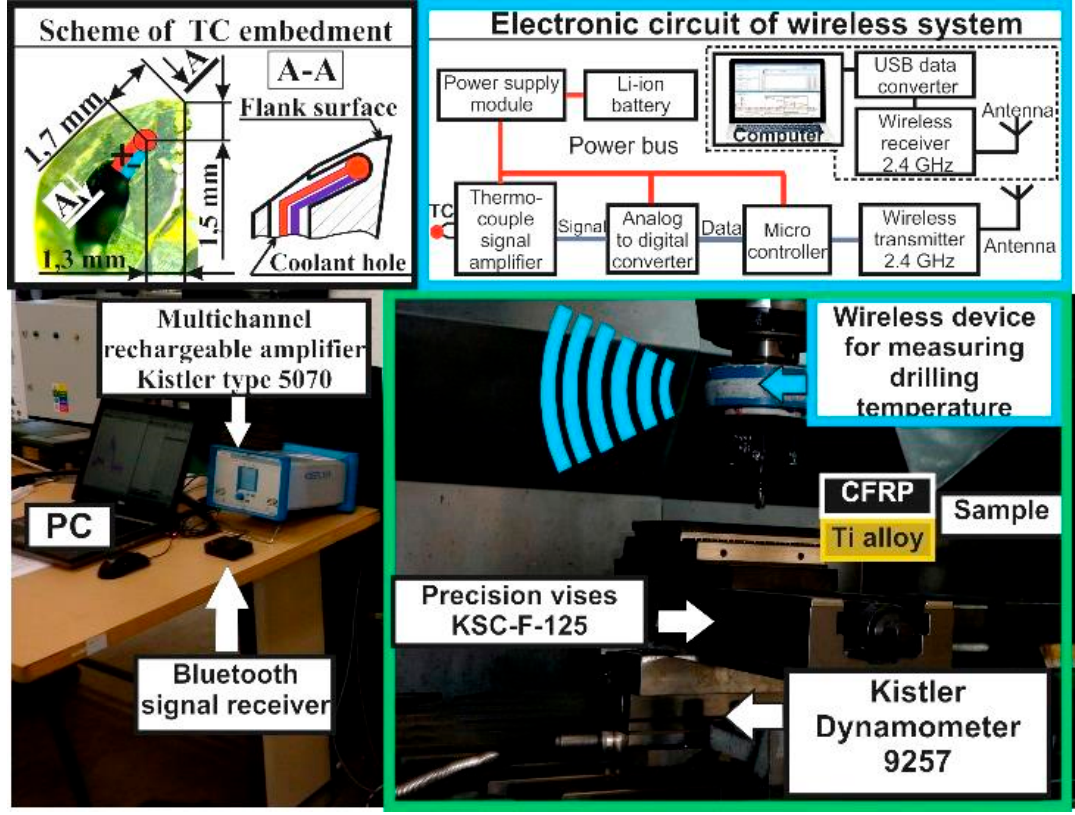
Figure 3. Experimental setup of the drilling tests. Table 4. Drilling performances and their levels and the design of the experiment according to the Taguchi orthogonal array L 9 .